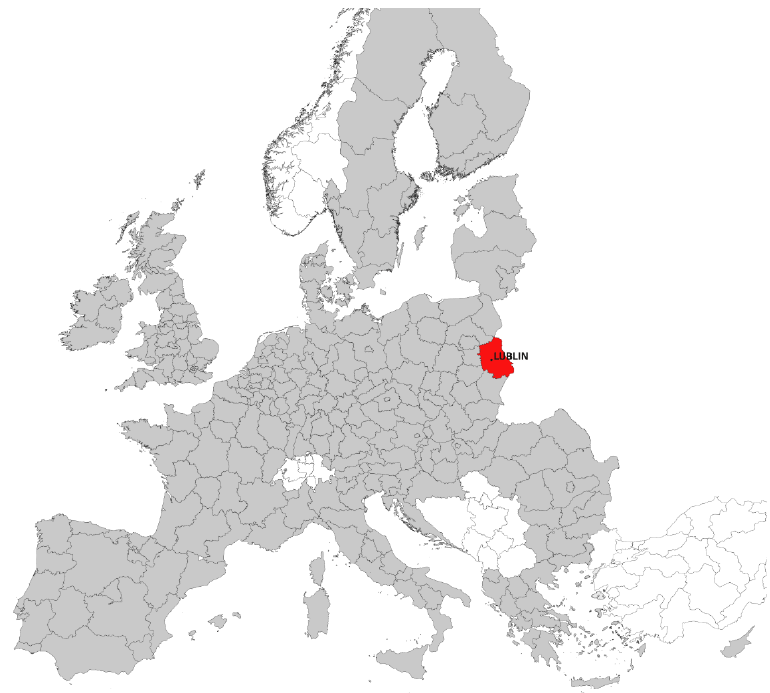
Figure 1: Location of Lublin and Lubelskie Voivodeship in the European